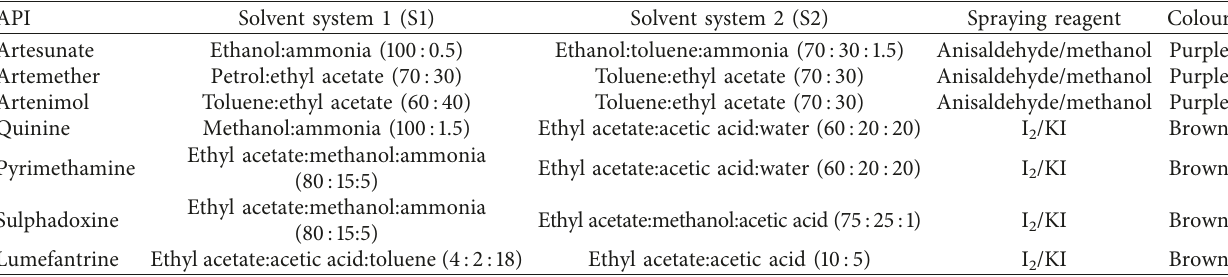
Table 2: Solvent systems for antimalarial active pharmaceutical